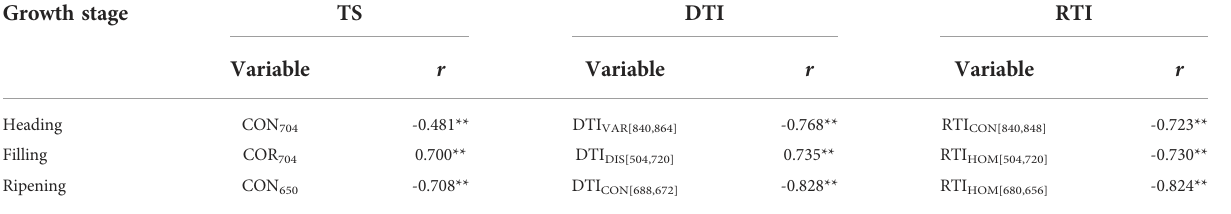
TABLE 6 Correlation coef fi cients ( r ) for the relationship between amylose content and textural measures. Growth stage